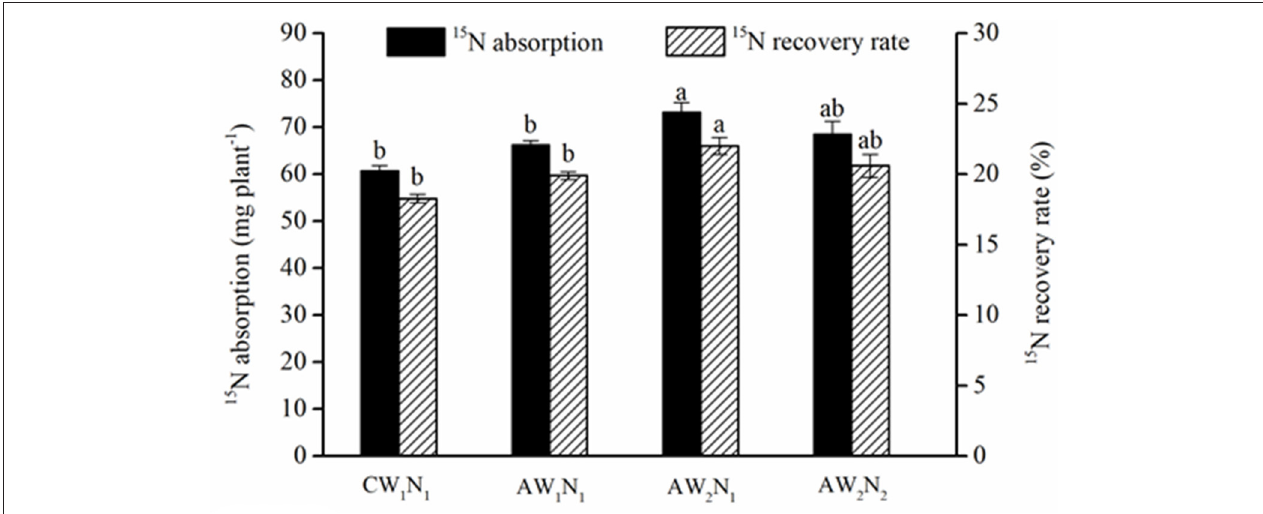
FIGURE 4 | The effects of water and N supply on 15 N absorption and recovery rate by tomato plants under alternate partial root-zone drip irrigation. Values are the means ± SE. Different lowercase letters in the columns denote significant differences among the treatments ( P ≤ 0.05).